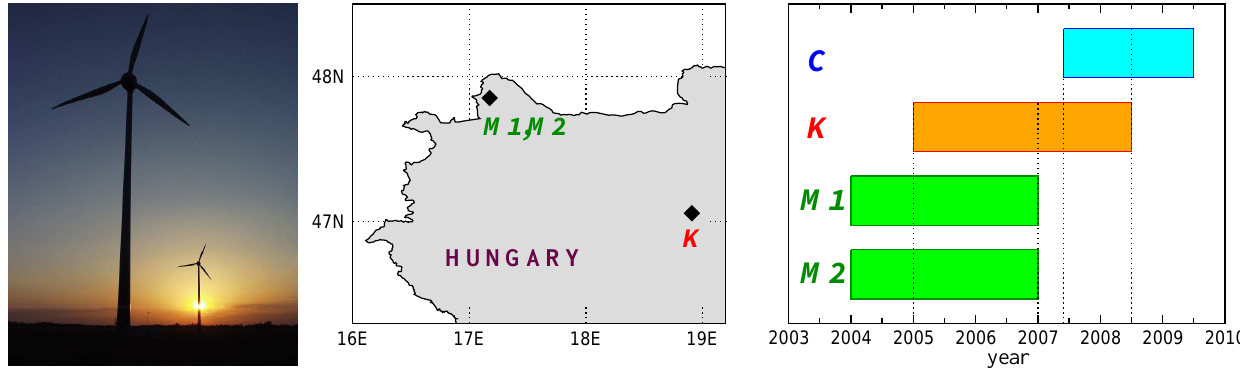
Figure 1. Sketch of the geographic setting of the wind turbines and timeline of the records. Heavy diamonds indicate the location of three Enercon E-40 wind turbines M 1 , M 2 (near Mosonszolnok, 47.816 ◦ N, 17.174 ◦ E) and K (Kulcs, 47.057 ◦ N, 18.914 ◦ E). The timeline il- lustrates the overlapping periods: 06/01/2007–06/30/2008 for C (consumer) and K records, and 01/01/2005–12/31/2006 for K and M time